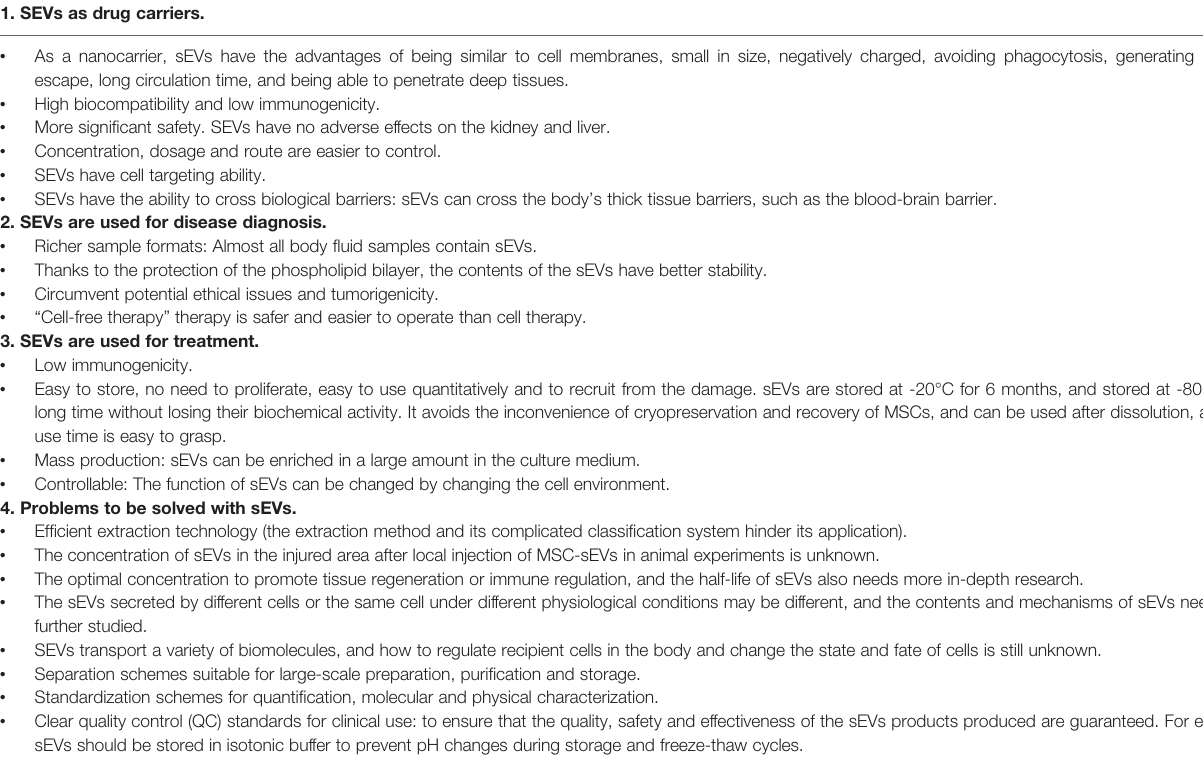
TABLE 2 | The advantages for MSC-sEVs treatment by comparison to MSCs donor